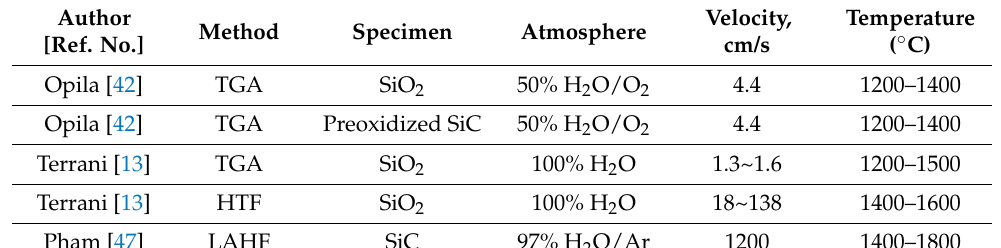
Table 1. Investigation conditions of volatilization rate of SiO 2 reported by various authors.